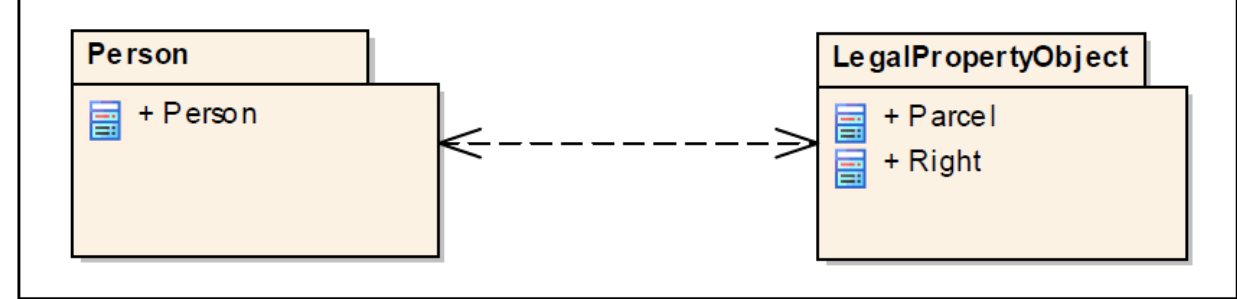
Figure 3. New cadastral data model based on the Legal Property Object concept, adopted from